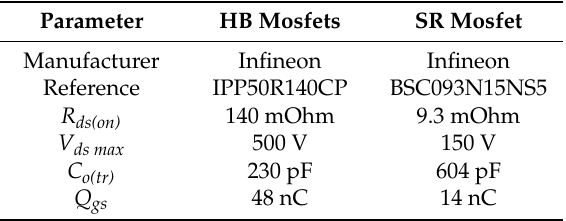
Table 2. MOSFETs characteristics.